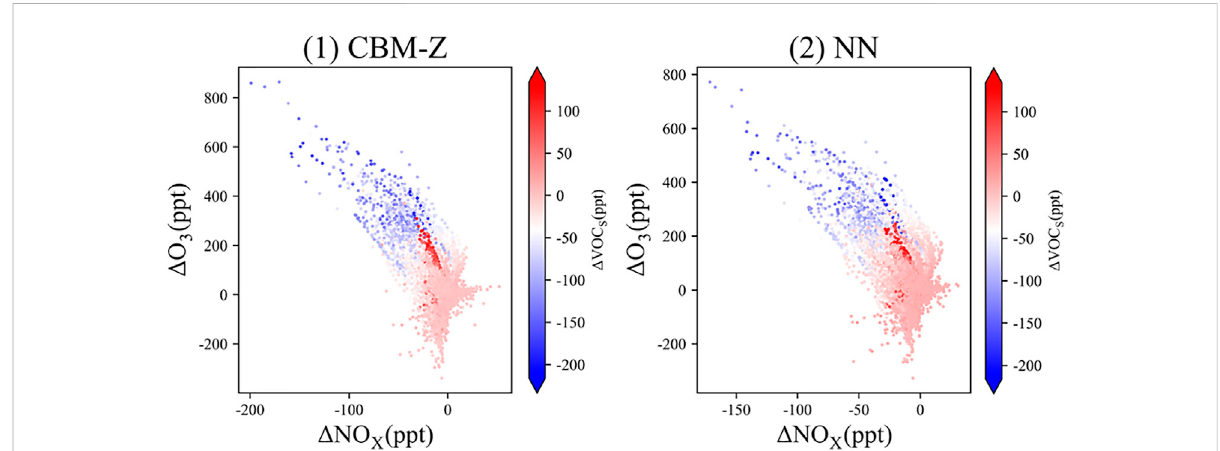
FIGURE 3 Scatterdiagramofrelationshipsbetweenthemeanconcentrationchangeperminuteat100 mabovegroundlevelofNO x ,VOCs(C 2 H 6 ,CH 3 O 2 , ETHP,HCHO,CH